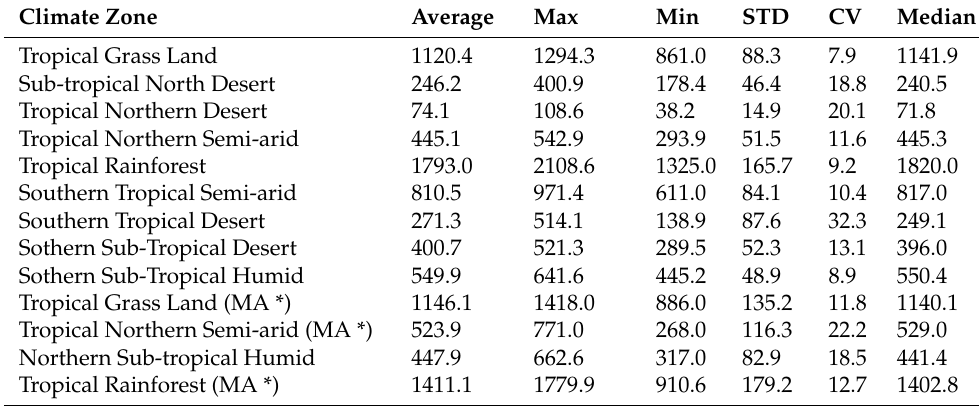
Table 1. Descriptive statistics for annual rainfall (in mm) for Africa’s climate zones from TAMSAT data (1983 to